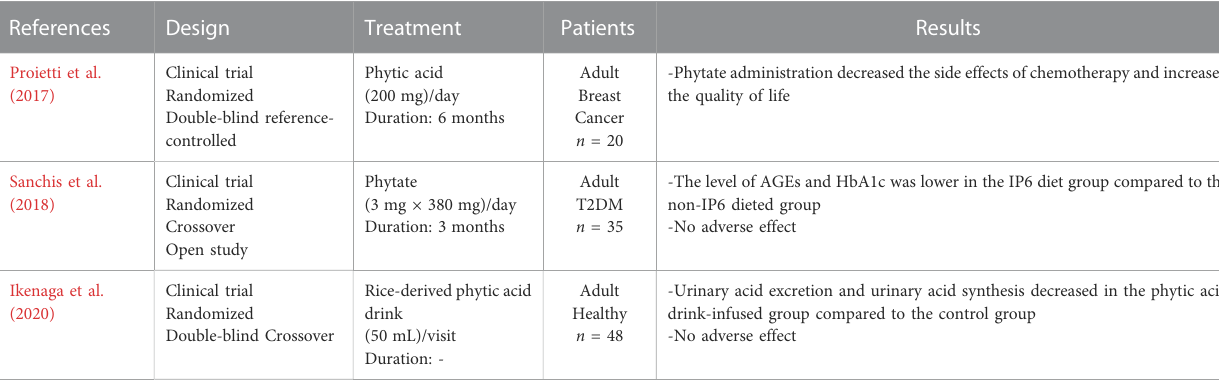
TABLE 1 Clinical trials with natural form of phytate in the last 5